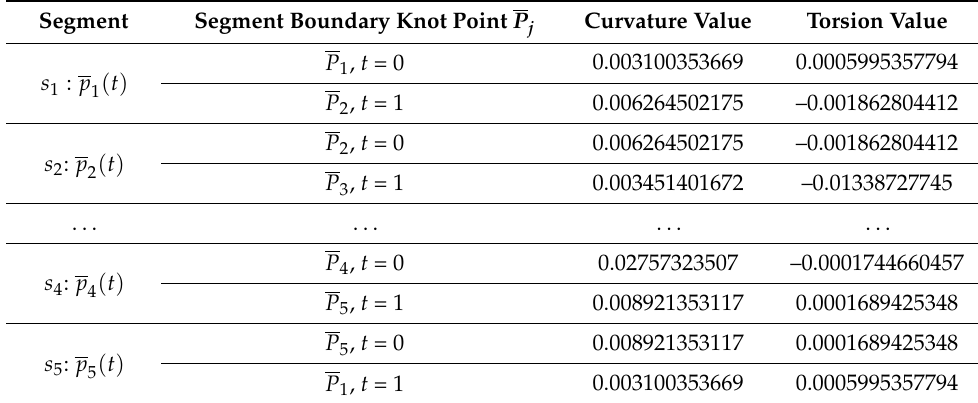
Figure 18. Closed fifth-degree Bézier spline curve of five segments. Table 7. Curvature and torsion values at boundary points of the segments.